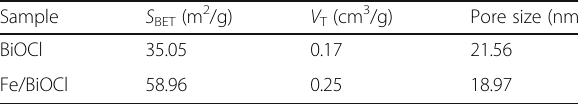
Table 1 Pore parameters of BiOCl and Fe/BiOCl (0.25)